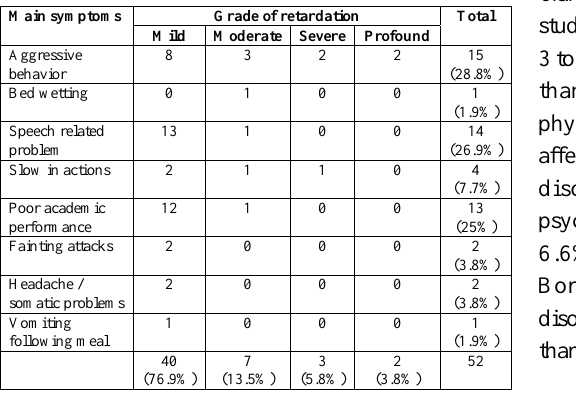
Mental and behavioural symptoms vs. grade of mental